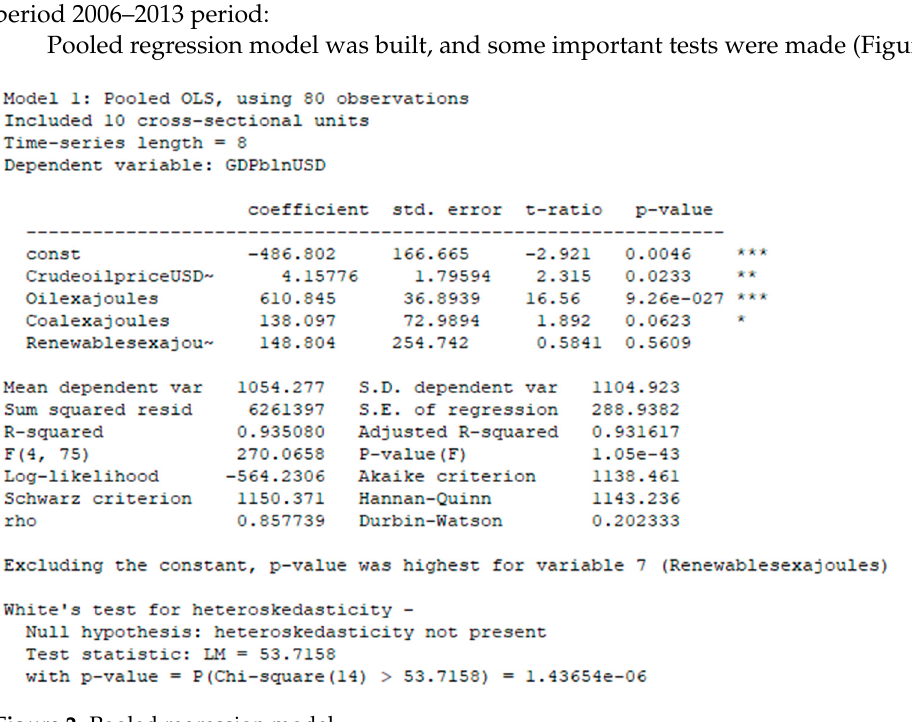
Figure 2. Pooled regression model.